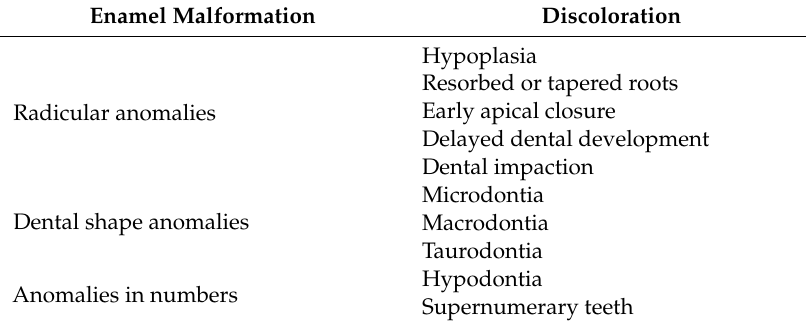
Table 2. Dental alterations associated with the use of anti-neoplastic